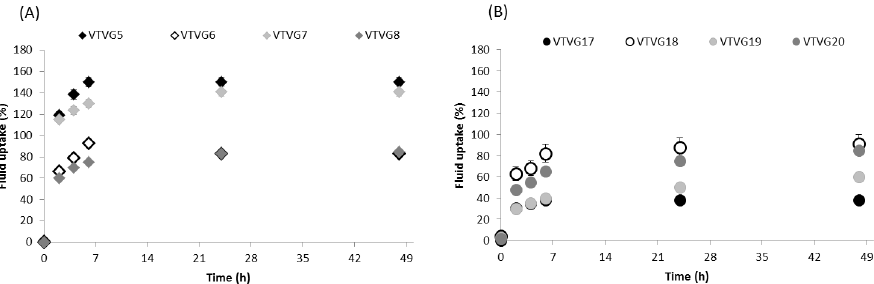
Figure 5. Fluid uptake capability of VTVGs vs. time (n = 3). VTVGs formulation based on PLA-PCL ( A ) and PLGA ( B ) polymers.